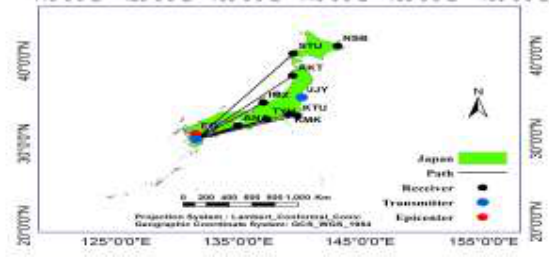
Figure 1 Relative positions of earthquake epicenter, transmitter, receivers, and receiver-transmitter paths. A Fresnel zone is an ellipsoidal region of space between and around a transmitter and a receiver. The Fresnel zone is very important in the discussion of the wave sensitive region at VLF/LF frequencies. For ionospheric anomaly detection by VLF waves, the wave-sensitive region for each propagation path is defined by the fifth Fresnel zone (Maekawa et al., 2006; Kasahara et al., 2008). In this research, the fifth Fresnel zone of the receiver-transmitter paths has been used to estimate the location of the earthquake. The fifth Fresnel zones are shown in Figure (2). With the coordinates of seven receivers and one transmitter accessible in the Japan VLF/LF network, the receiver-transmitter paths and their effective area, the spatial layer includes the area covered by the fifth Fresnel zone of the propagation paths and the 300 km area around the transmitter and receivers of VLF/LF network were built in a GIS environment to estimate the location of the earthquake epicenter.